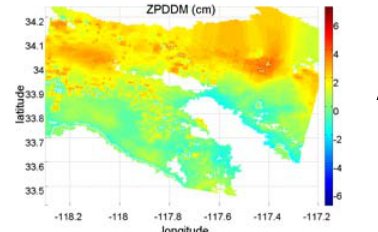
Figure8. Zenith Path Delay Difference Map derived from MODIS and MERIS